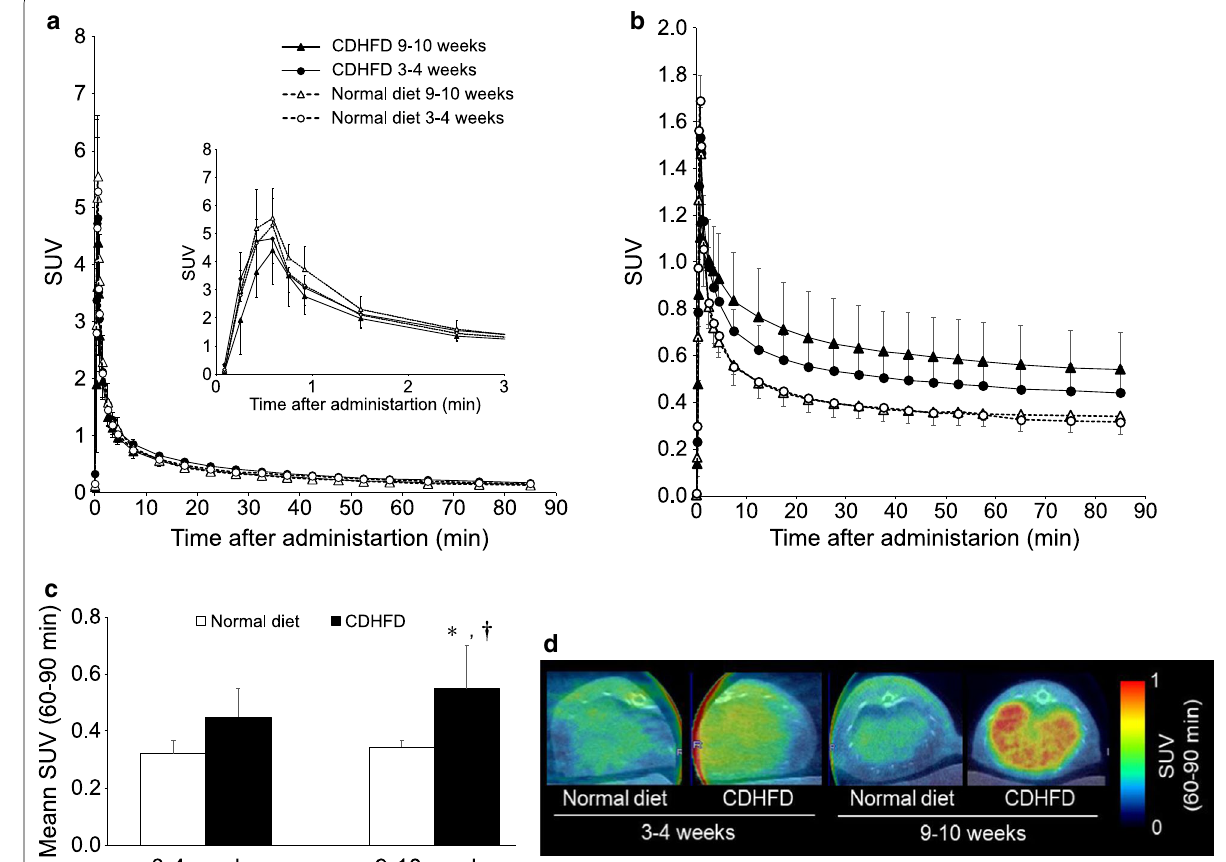
Fig. 4 SUV profile and representative colour-coded PET images. a Left ventricular time-activity curve and b hepatic time-activity curve after 18 F-FPP-RGD 2 administration. c Mean SUV and d representative PET/CT fusion images 60–90 min after expressed as means